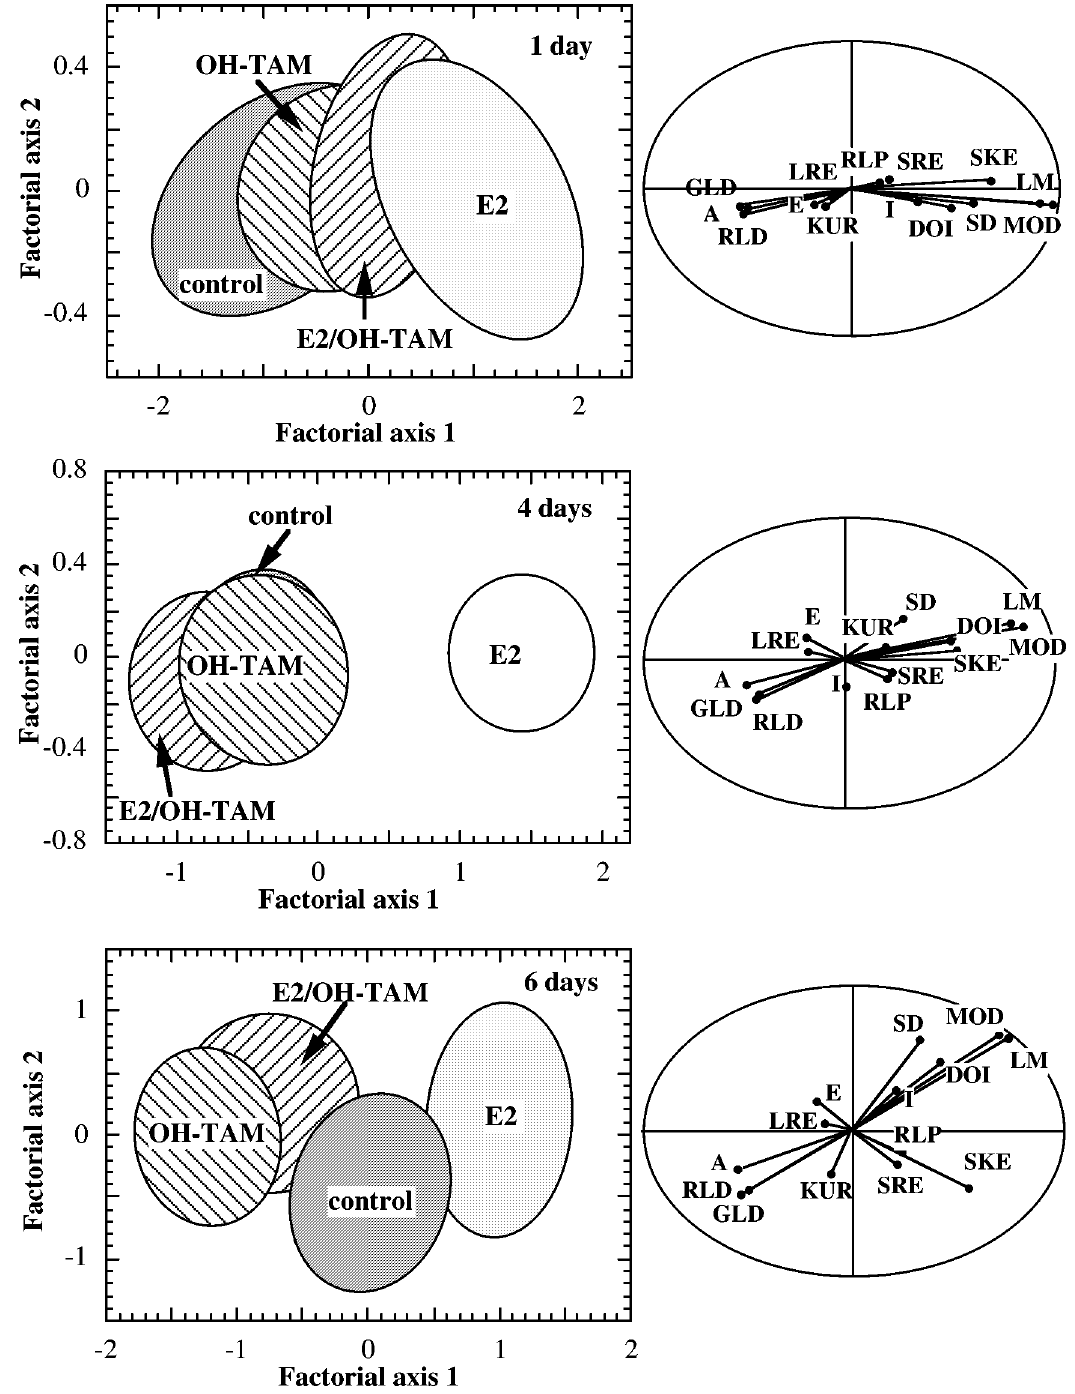
Fig. 8. Scattergram of the treated and untreated cells in the factorial principal plane determined by the multifactorial discriminant analysis on the Feulgen-stained nuclei. Each axis is a linear combination of the 14 axes related to the 14 parameters computed for each nucleus. Four groups were analysed control, E2, OH-TAM and E2/OH-TAM treated cells for different times of treatments. Left hand: ellipses delineate the 95% tolerance region around the center of gravity of each group. Right hand: projections of the 14